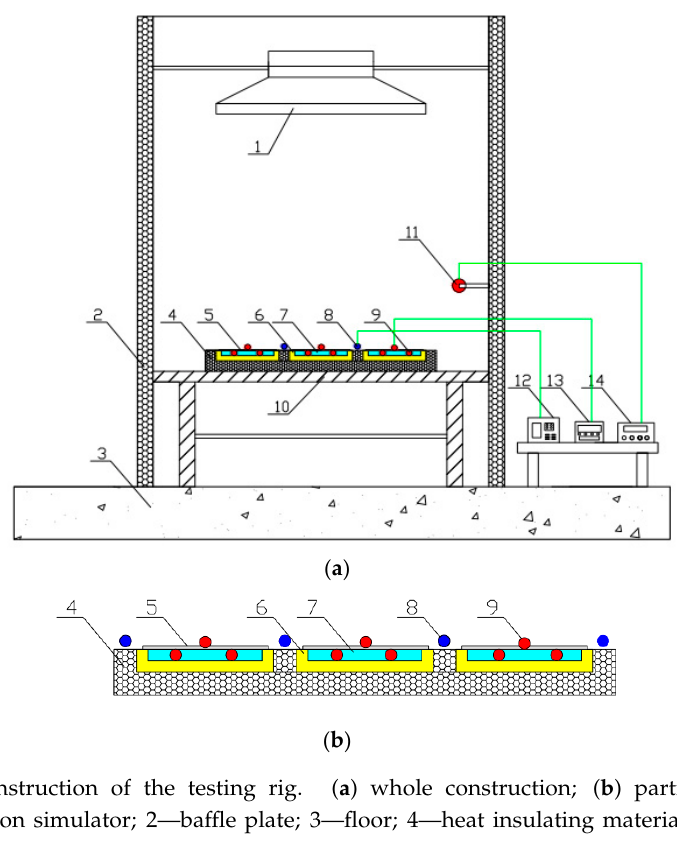
Figure 6. Construction of the testing rig. ( a ) whole construction; ( b ) partial enlargement. 1—solar